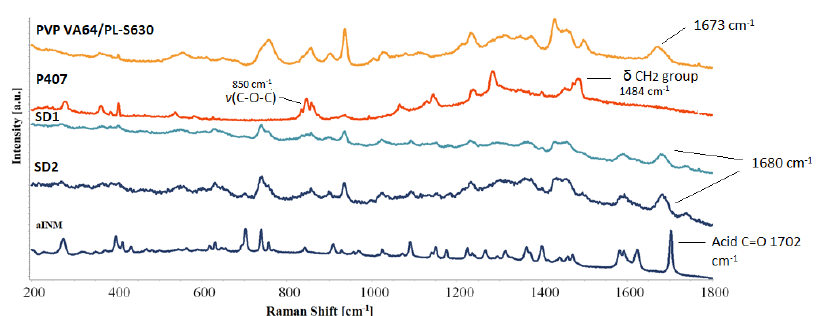
Figure 5. Raman spectra of crystalline INM, polymeric carriers and chosen SD formulations (30% INM), which shows interaction via hydrogen bonding as a result of the shift in the amide C=O carbonyl stretch of PL-S630 and PVP VA64. The low intense peak at 1732.00 cm − 1 corresponds to the vinyl acetate C=O carbonyl.